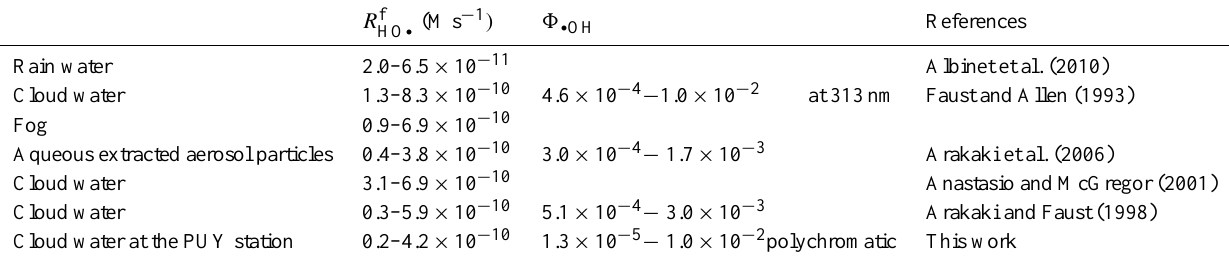
(cid:113) (Ms − 1 ) and polychromatic quantum yield ( (cid:56) Table 3. R f HO